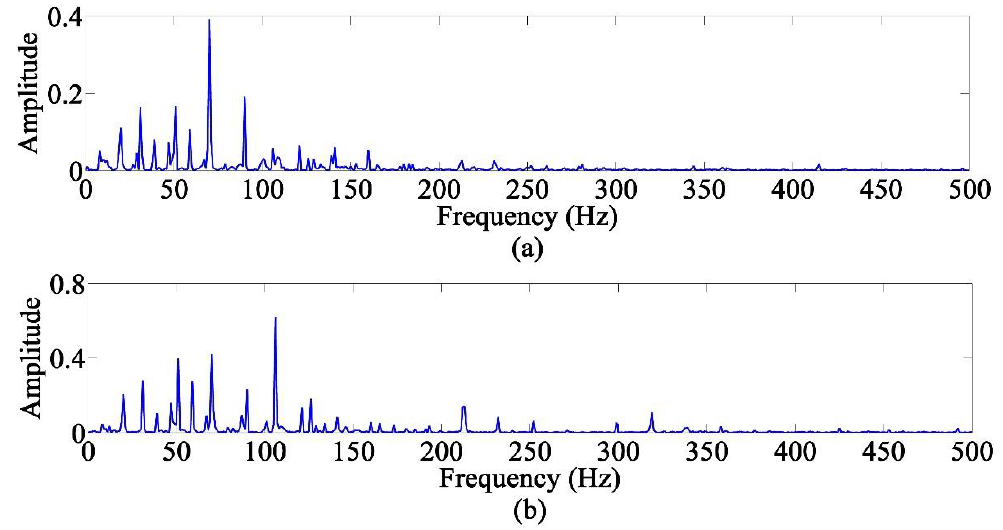
Figure 15. The Hilbert envelope spectra of the extracted fault signals after KICA. ( a ) The first fault signal. ( b ) The second fault